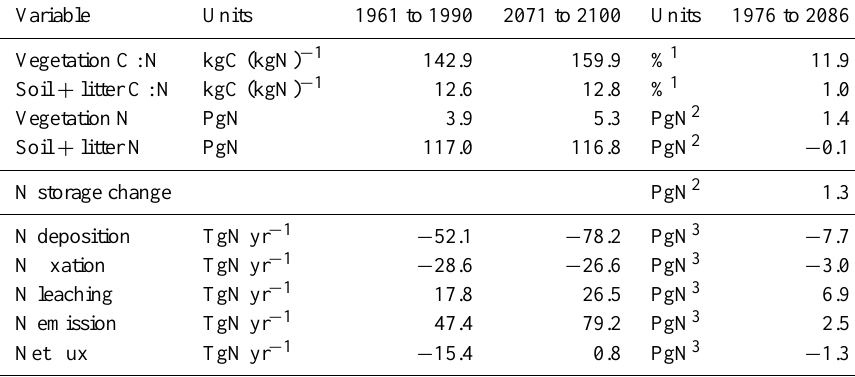
Table A3. Changes in N stocks and fluxes for the C–N version of the model under all scenarios.